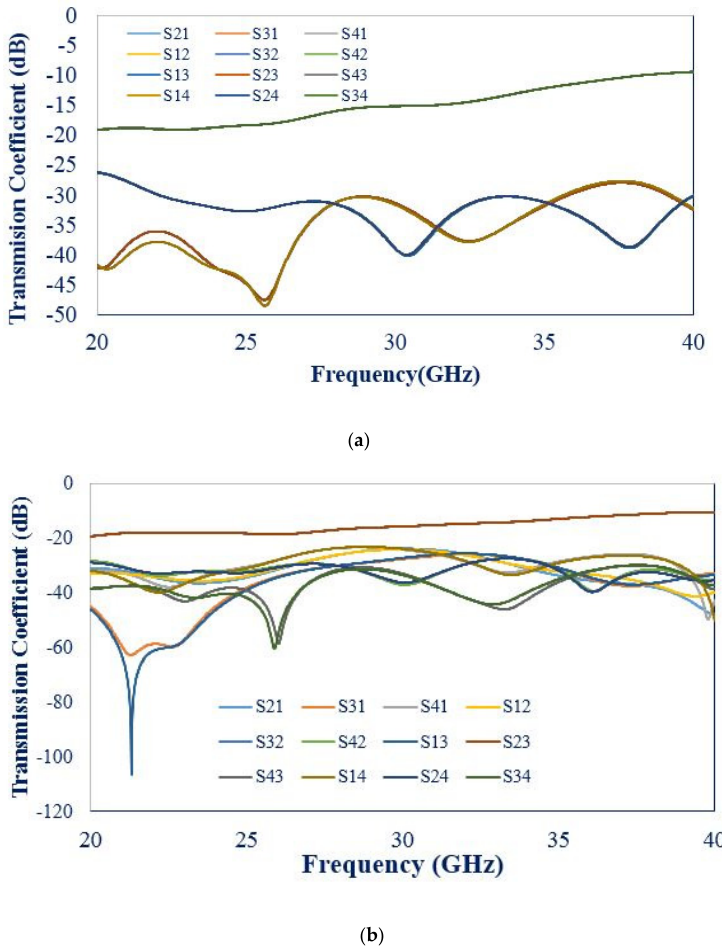
Figure 7. Transmission coefficient of ( a ) Figure 6a (case-I); ( b ) Figure 6b (case-II). This indicates that the isolation between the second port and third port is better than 15 dB for the frequency range of 30 GHz to 40 GHz. Further modifications are made to the structure as shown in Figure 8, which improved the isolation. These provided better re- sults and a detailed description is given below. Figure 8 shows the chosen four-element MIMO antenna geometry after analyzing the results in terms of S-parameters. The antenna elements are arranged in an orthogonal ro- tational manner as illustrated in Figure 8a. As shown in Figure 8b, the ground plane is interconnected using a circular ring connecting a slotted plus shape. Figure 8c presents the 3D view of the proposed design. ( a )